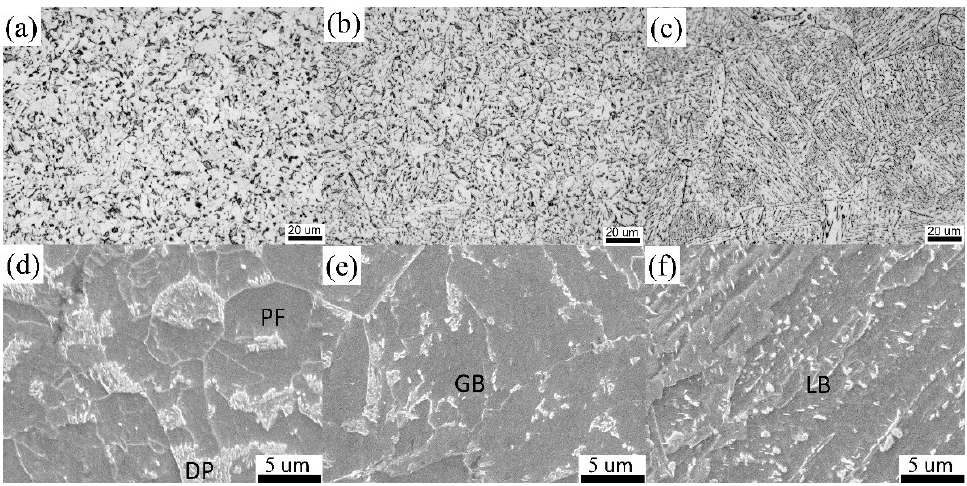
Figure 2. OM and SEM of the different sampling positions of the X80 heavy-wall heat-induced seamless bend: ( a , d ) S1, ( b , e ) S2, and ( c , f ) S3. seamless bend: ( a , d ) S1, ( b , e ) S2, and ( c , f )